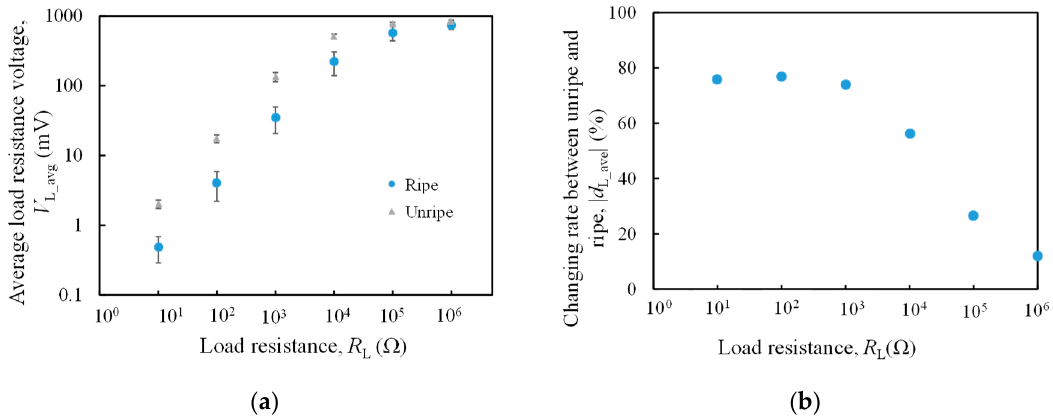
Figure 6. ( a ) The load resistance voltage of unripe and ripe as a function of load resistance and ( b ) the changing rate of load resistance voltage between unripe and ripe fruits.